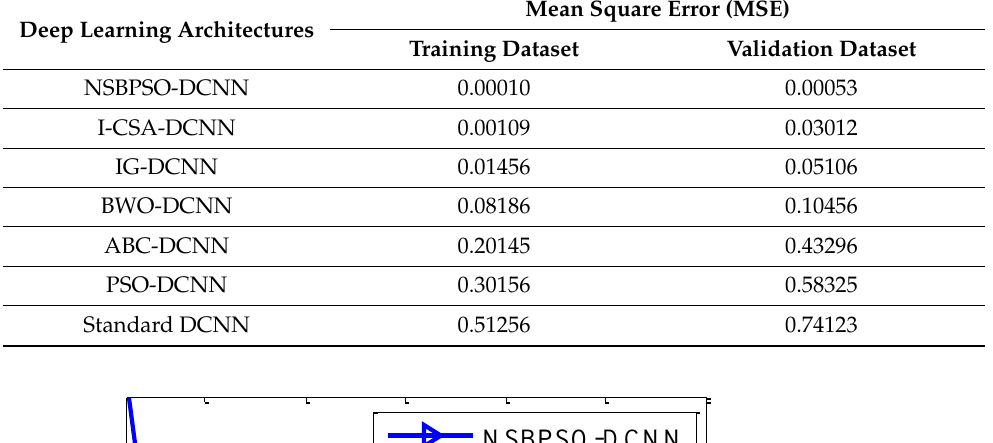
Table 5. The value of MSE for the proposed architectures.